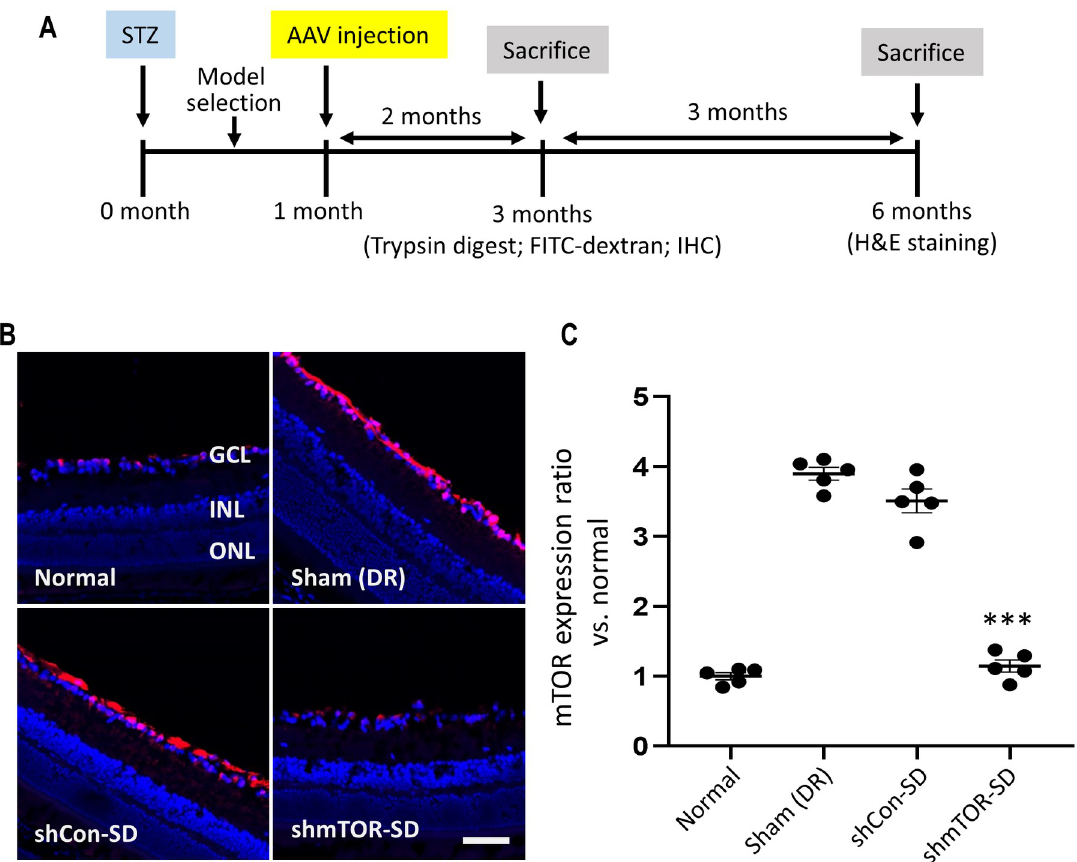
Fig 1. In vivo characterization of rAAV2-shmTOR-SD. (a) Experimental schematic. (b) Immunohistochemistry performed on transverse retinal sections sampled two months post-intravitreal injection showed that the therapeutic virus vector is able to effect the long-term inhibition of mTOR, which was elevated in control mice and those injected with rAAV2-shCon-SD. Scale bar = 50 μ m. (c) Quantification of mTOR expression levels, relative to normal mice. GCL, ganglion cell layer; INL, inner nuclear layer; ONL, outer nuclear layer. Data represented as mean ± SEM (n =